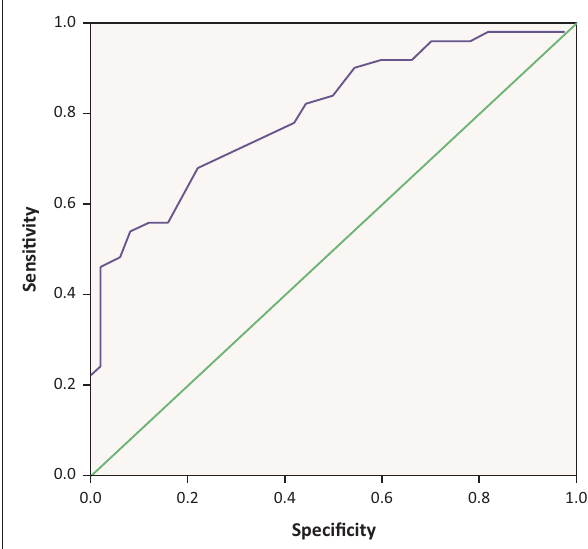
FIGURE 1: Receiver operating characteristic curve analysis to evaluate mean platelet volume utility in discriminating between healthy controls and irritable bowel syndrome patients, Babol, Iran, 2015–2017.